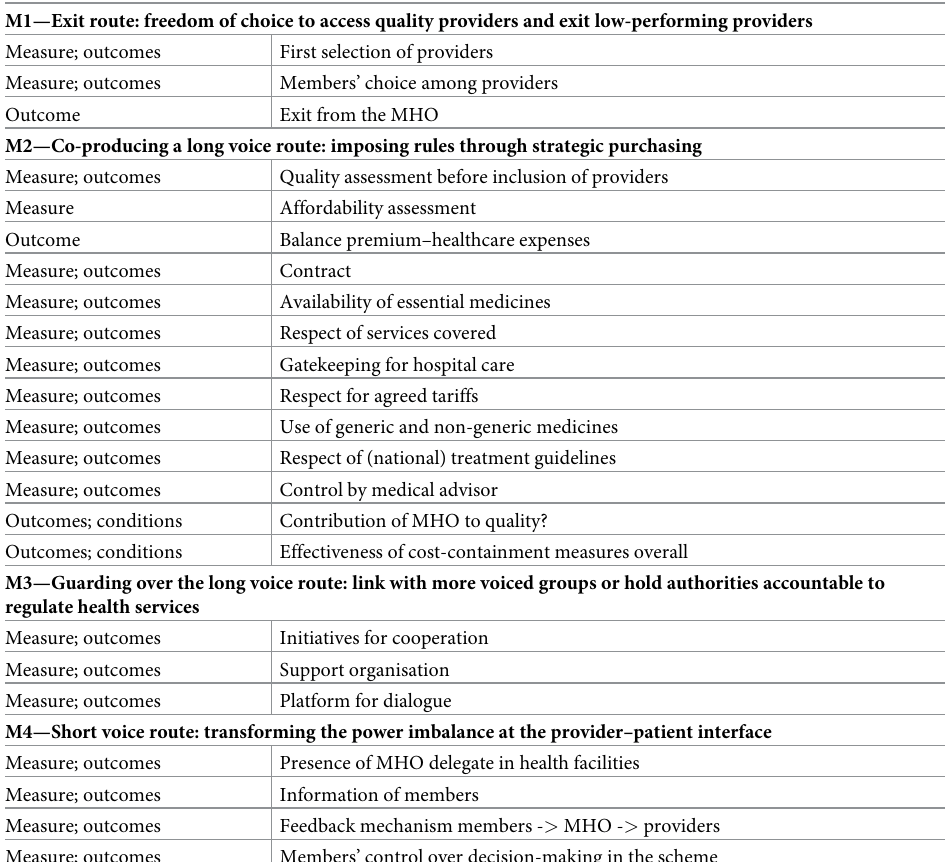
Table 2. Analytical